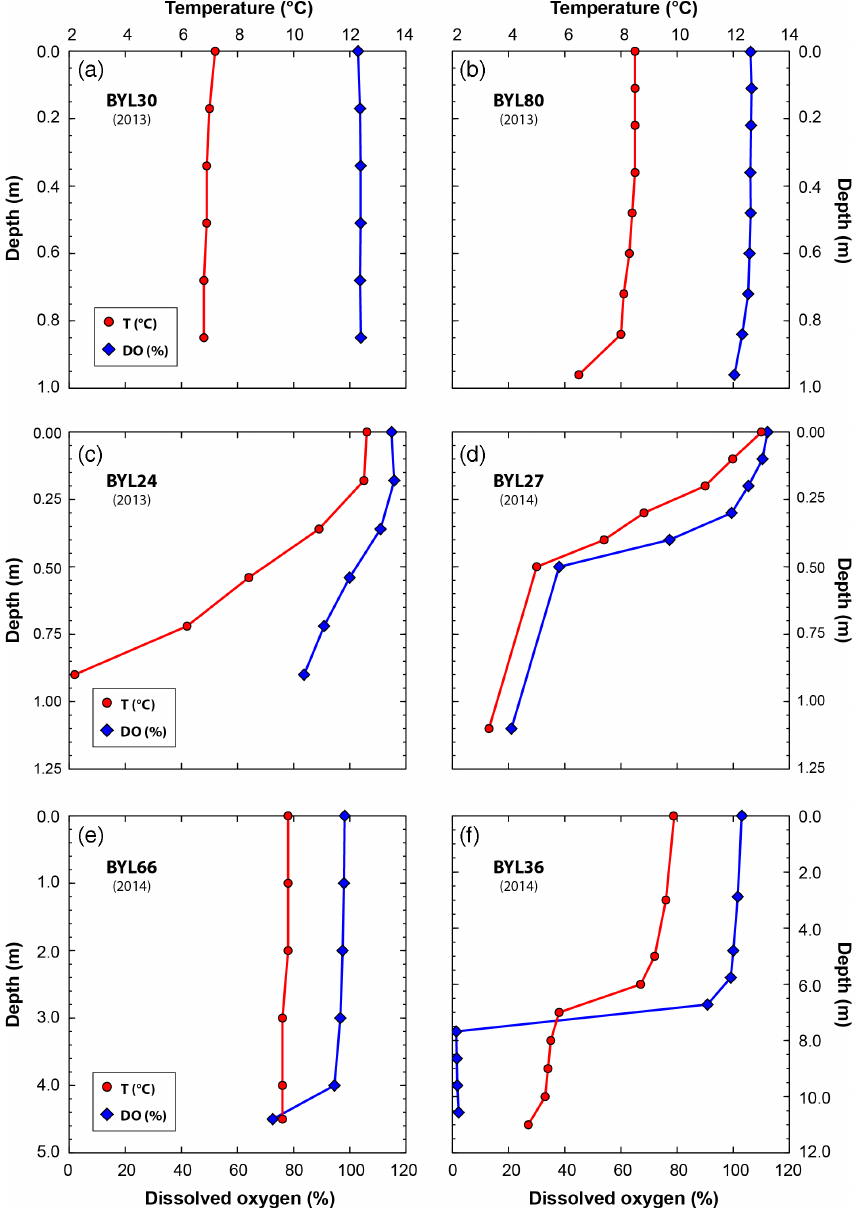
Figure 3. Temperature ( ◦ C; upper x axes) and dissolved oxygen (%; lower x axes) profiles for polygonal ponds BYL30 (a) and BYL80 (b) , trough ponds BYL24 (c) and BYL27 (d) , and lakes BYL66 (e) and BYL36 (f) . Some profiles ( a–c ) were taken in July 2013, whereas the others ( d–f ) were taken in July 2014. Note the different vertical scales